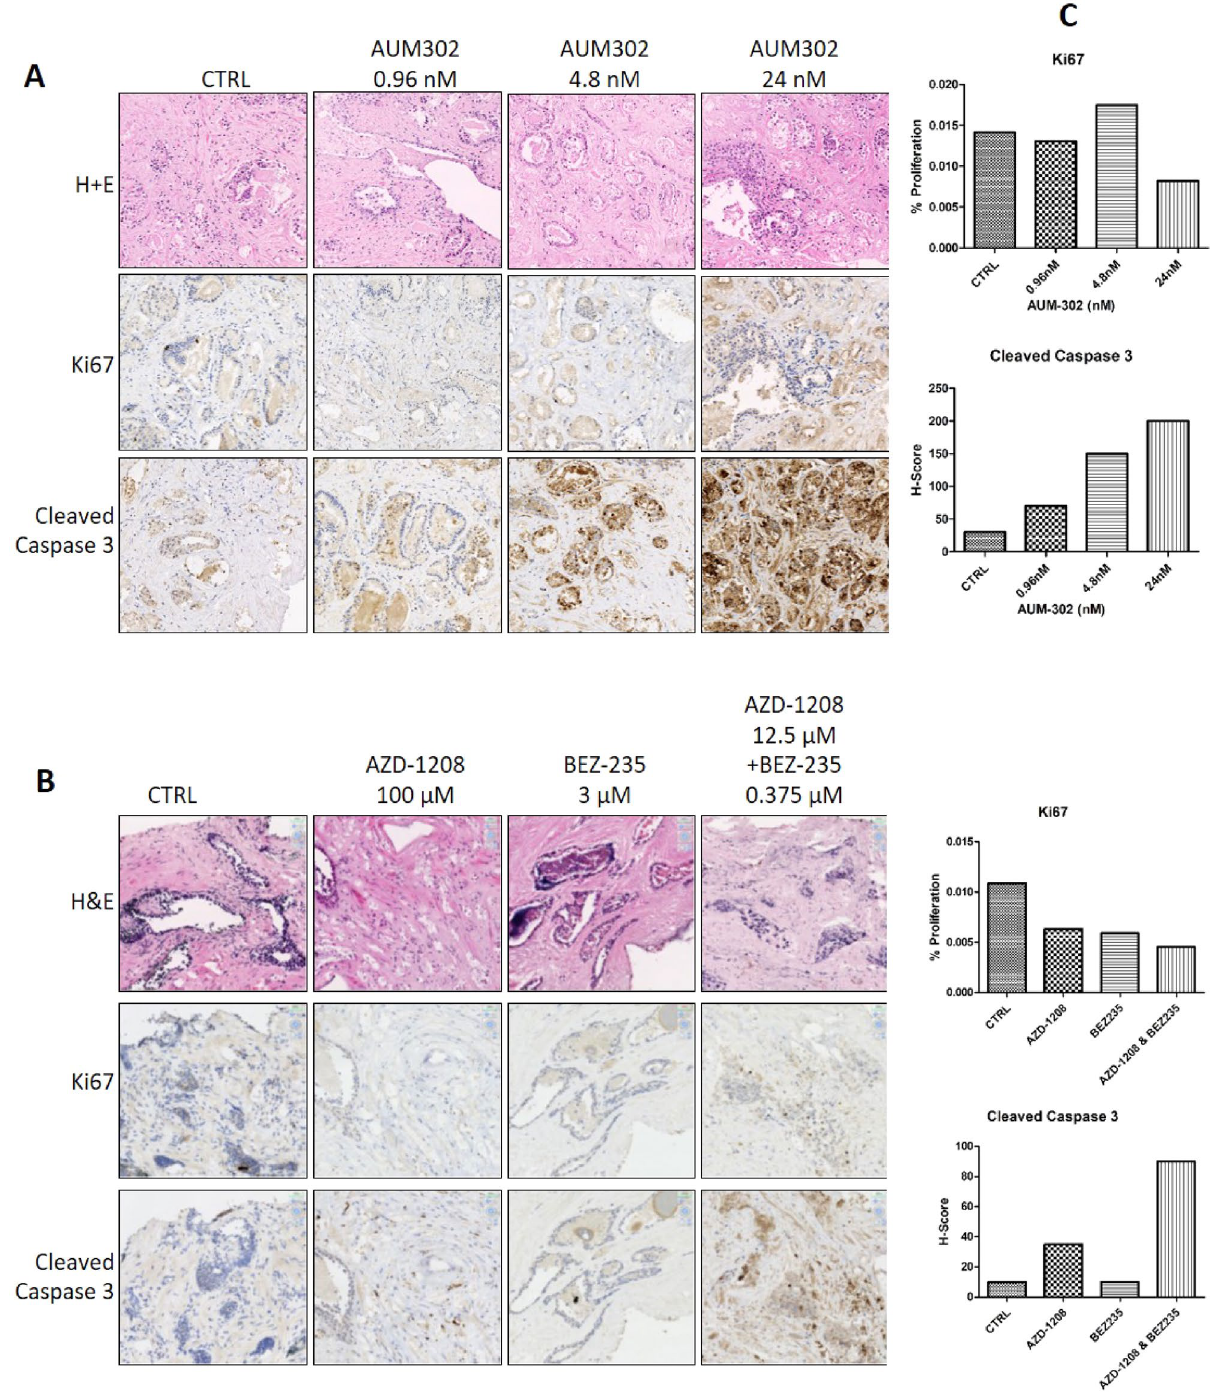
Figure 5. Morphology, proliferation and apoptosis of prostate cancer cells were significantly altered following treatment with AUM302 or a combination of AZD-1208 and BEZ235. ( A ) Human prostate tissue obtained from a biopsy was cultured for 72 h and treated with varying concentrations of AUM302 or ( B ) a combination of AZD-1208 and BEZ235. H&E staining, Ki67 and Cleaved caspase 3 were used to assess changes in morphology, proliferation and apoptosis, respectively. Brown staining indicates a positive antibody reaction, i.e. higher proliferation or apoptosis. Pink staining is specific for the cell cytoplasm, and blue for the nuclei. ( C ) Quantification was carried out using H scoring (cleaved caspase 3) and QuPath positive/negative nuclei count